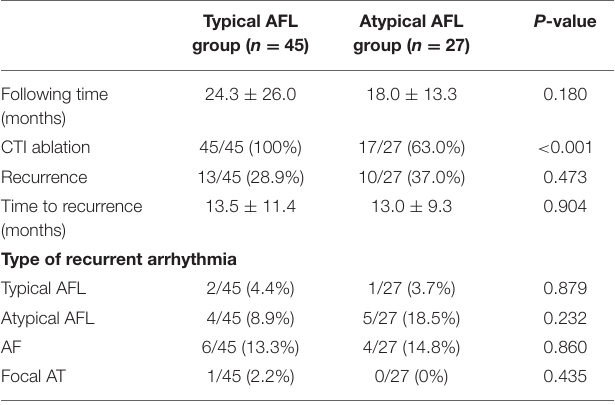
TABLE 3 | Ablation outcomes of the typical and atypical AFL